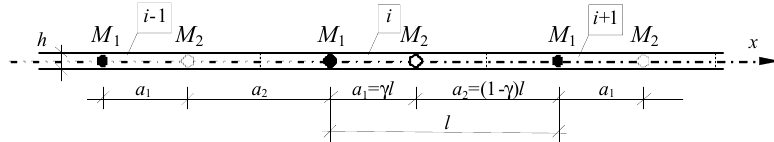
Figure 2. Fragment of periodic beam with a periodically distributed system of two concentrated masses, M 1 and M 2 .